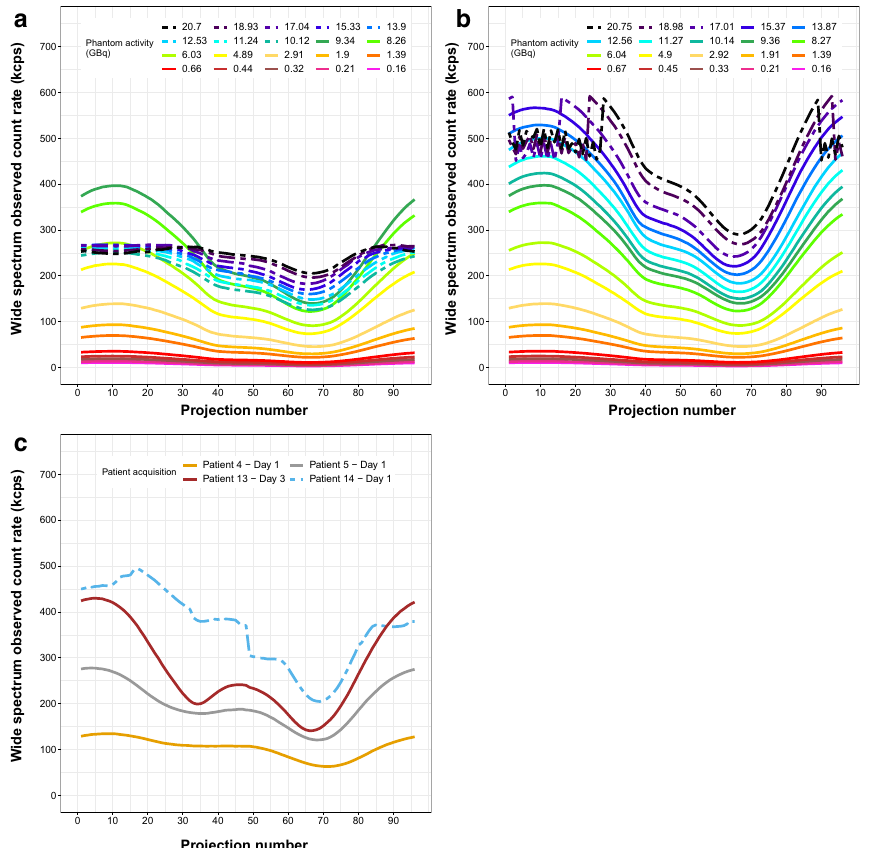
Fig. 1 Observed wide‑spectrum count rate versus projection number for the phantom (Intevo) with both detectors activated ( a ), only detector 1 activated ( b ), and selected patient acquisitions ( c , Symbia, both detectors activated). Dashed lines correspond to acquisitions with saturated